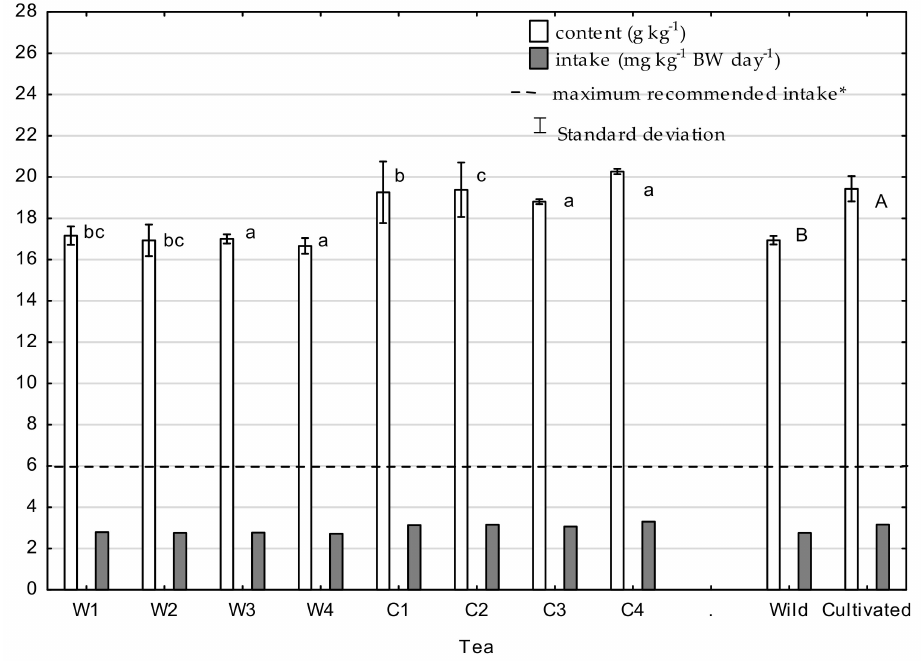
Figure 3. Caffeine content in tea and daily intake with infusion; * maximum recommended intake not associated with adverse effects such as general toxicity (6 mg · kg − 1 bw · day − 1 ) [27,45]. Means with different letters are significantly different, according to Tukey’s test ( p ≤ 0.05). W1-wild